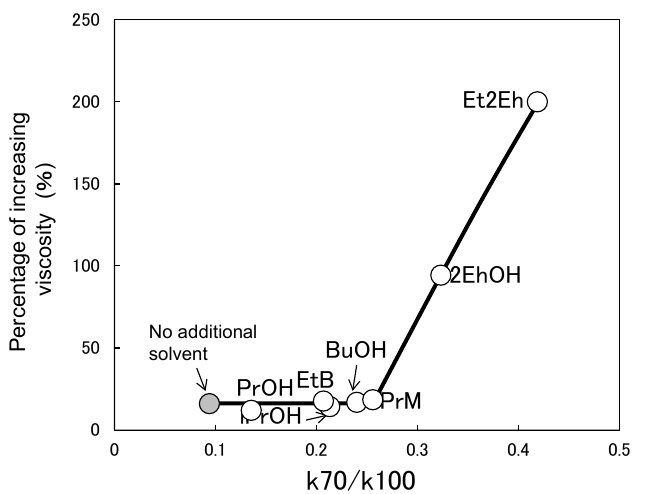
Figure 13. Relationship between the k70/k100 of the additional solvent and the percentage of increasing viscosity.